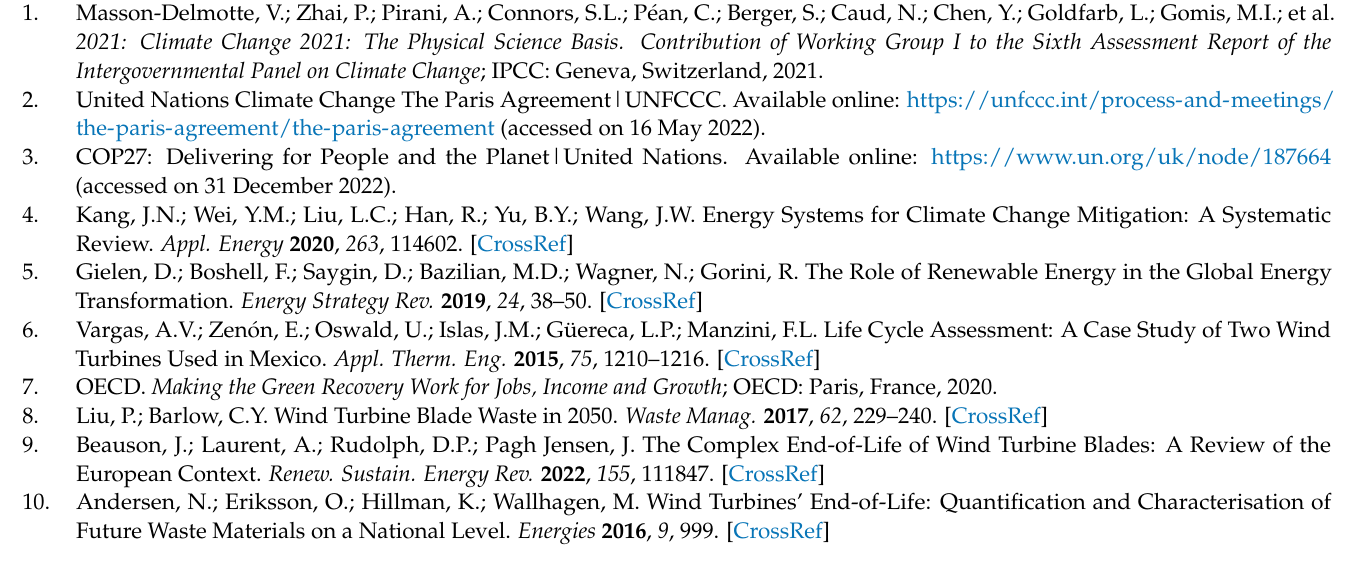
Figure A11. A blade-made bench [49].